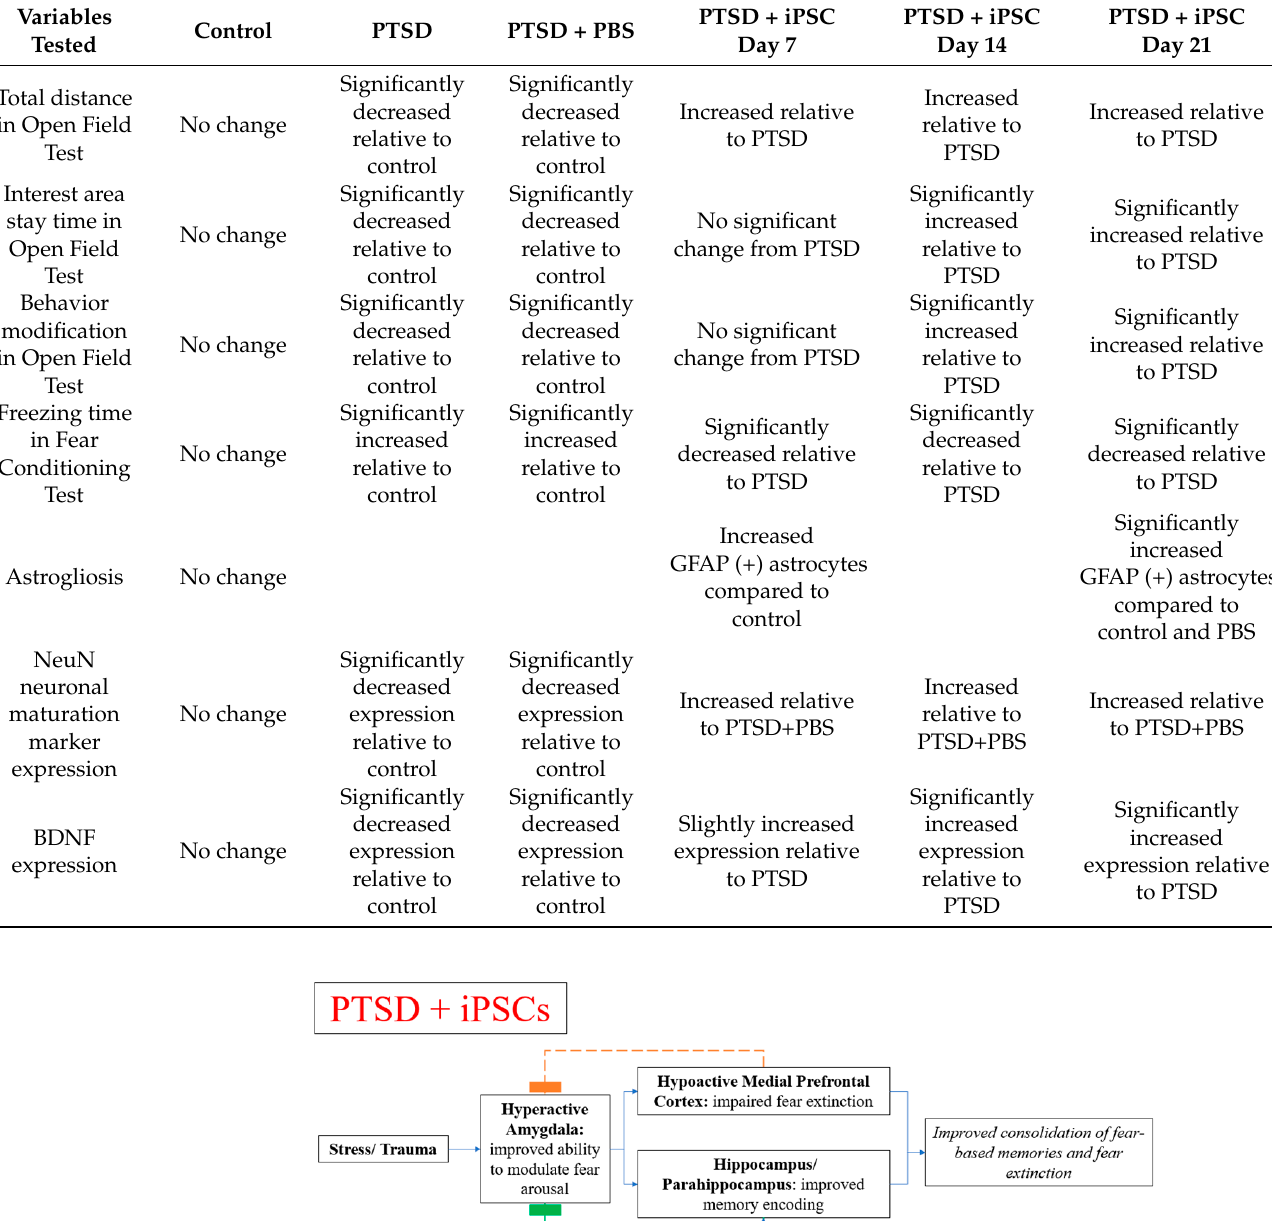
Table 1. Summary of results from Liu et al. [101]. Legend: PTSD—post traumatic stress disorder group (as induced by previously established protocol), PBS—phosphate buffer solution (does not contain any stem cells), iPSC—induced pluripotent stem cells, Day #—indicates number of days post-transplantation.